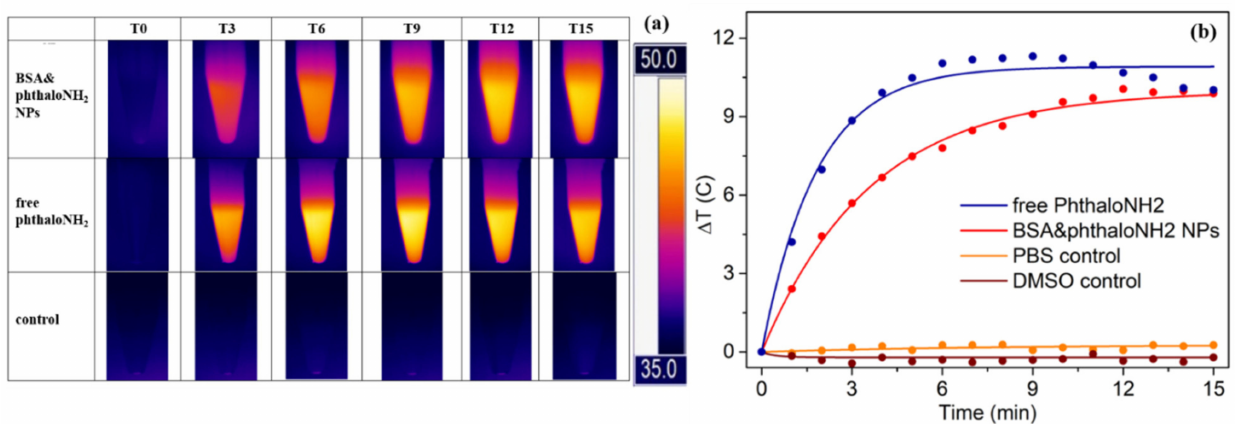
Figure 8. ( a ) Real-time photothermal images recorded under 785 nm laser irradiation through 15 min every 3 min of BSA&phthaloNH 2 NPs, free phthaloNH 2 , and PBS (as control); ( b ) Heating curves of free phthaloNH 2 (blue), BSA&phthaloNH 2 NPs (red), control PBS (orange), and DMSO (brown) solutions plotted against 15 min irradiation